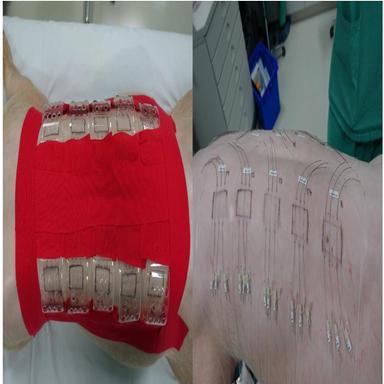
dOFM sampling setup. Left picture: dorsal side of pig covered overnight after first dose application (t = 0 h). Right picture: dorsal side of pig during dOFM sampling (t = 11 h – 24 h).